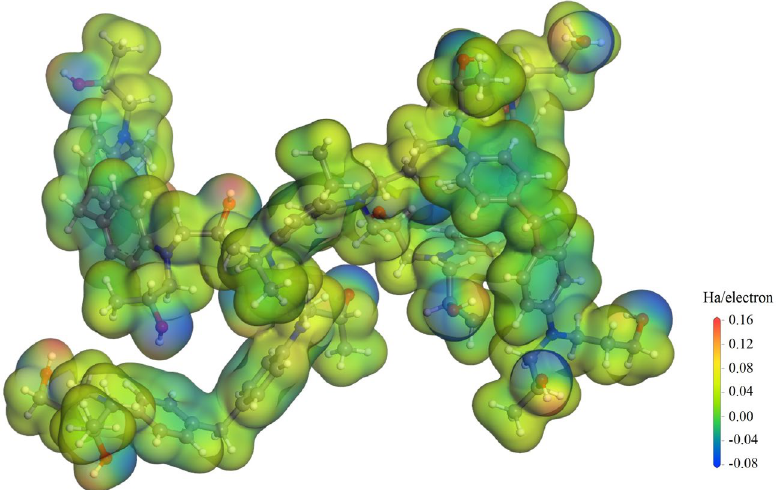
Figure 4. Electrostatic potential in TGDDM-DETDA crosslinked EP polymer, as described by color contours on electron density isosurface of 0.05 Å −3 , in which the gray, blue, red, and white spheres denote carbon, nitrogen, oxygen, and hydrogen atoms, respectively.